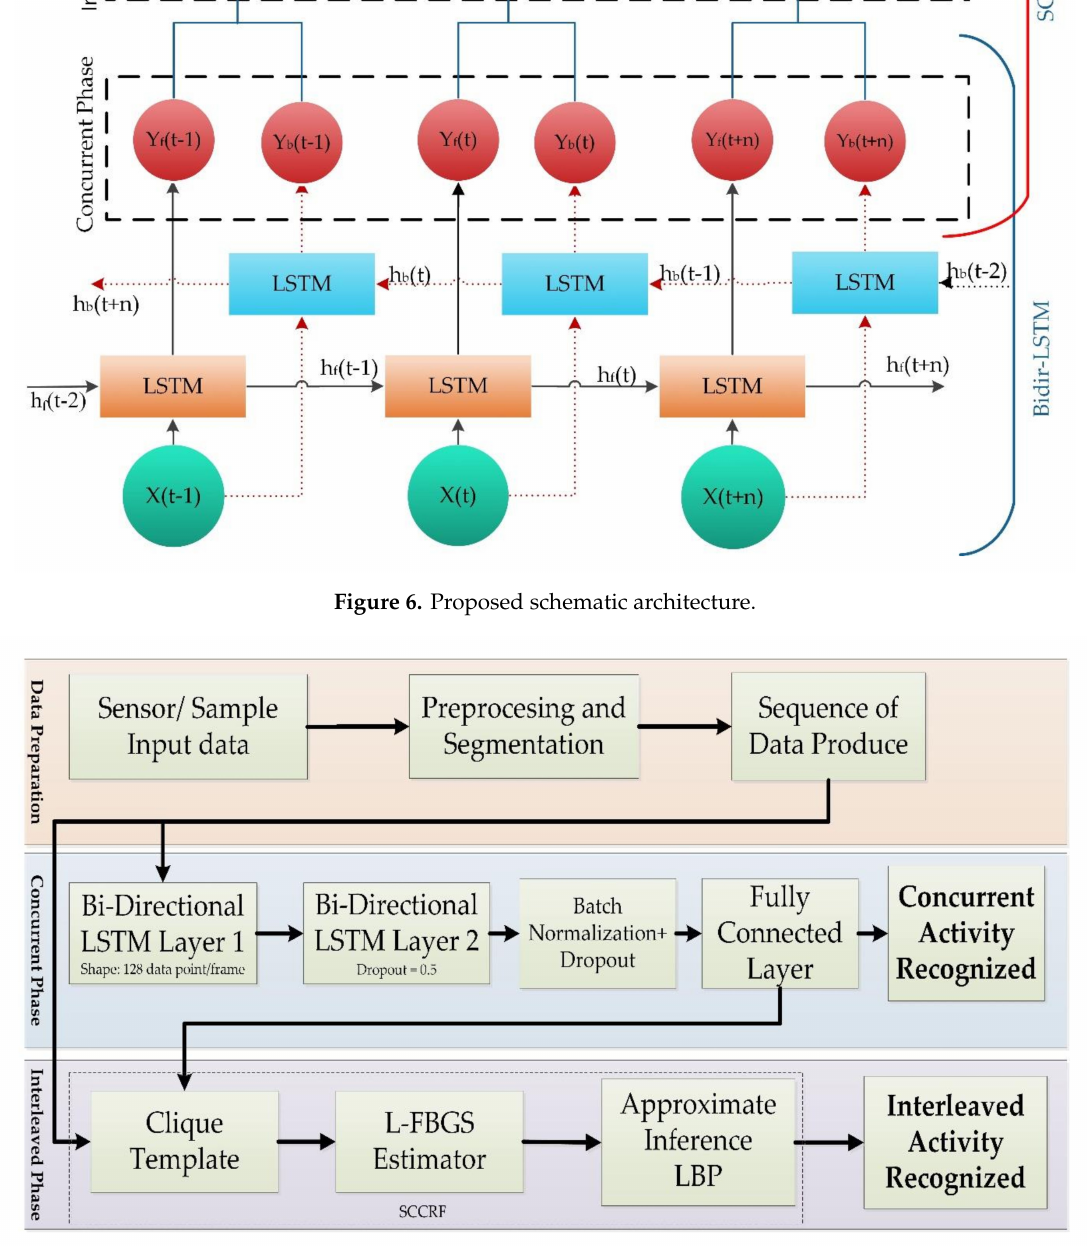
Figure 7. Overall system structure of the proposed